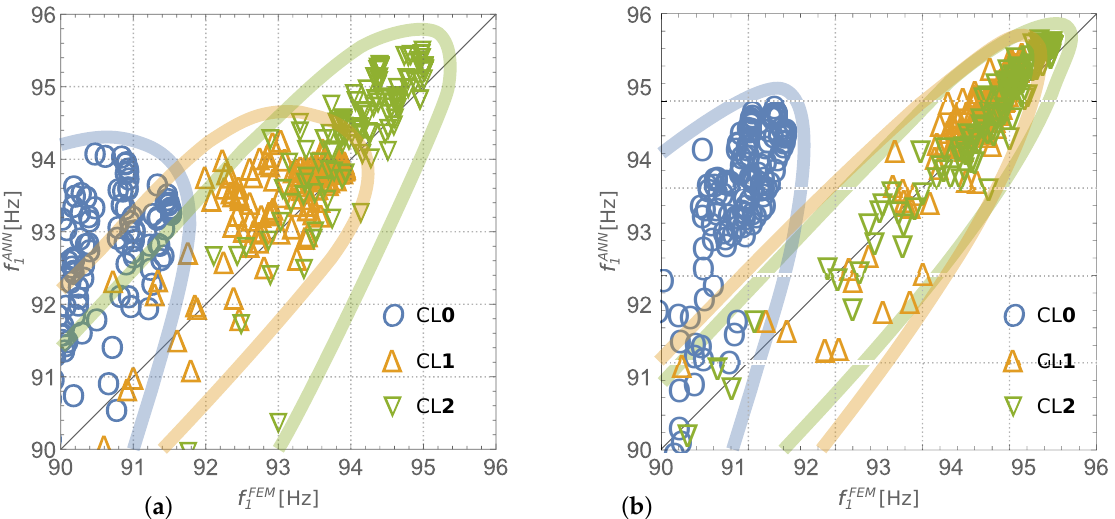
Figure 9. The accuracy of ( a ) ANN 1